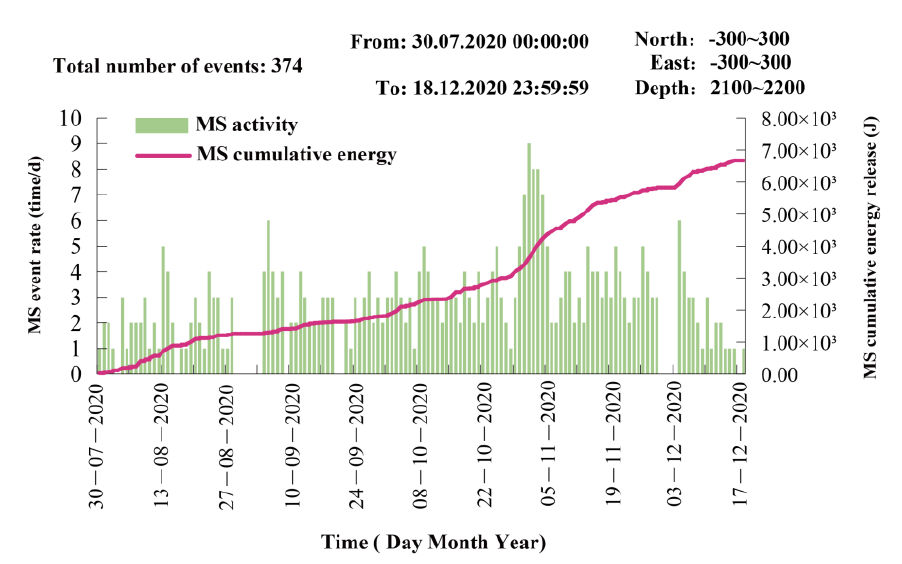
Figure 6. Relationships among the activity rate of microseismic events, accumulative energy loss, and time.